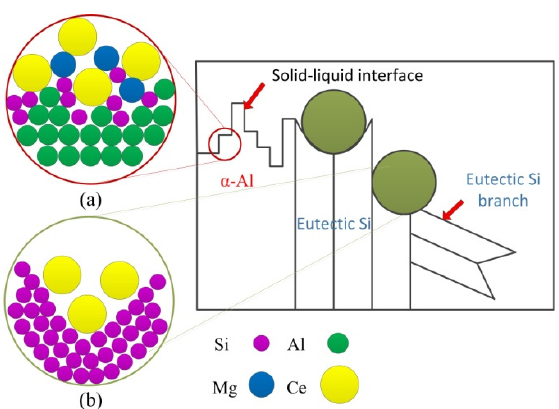
Figure 6. Schematic of grain refinement and modification process. ( a ) (Al, Si, Ce, Mg) intermetallic compounds, ( b ) Enrichment of Ce atoms.